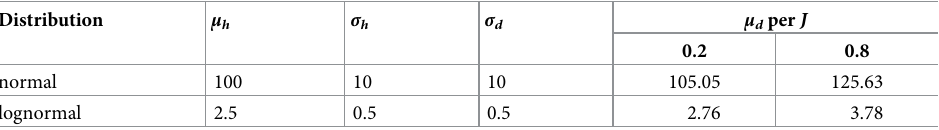
Table 1. Overview of simulation scenarios with J = Youden-Index, d = diseased population, and h = healthy population.